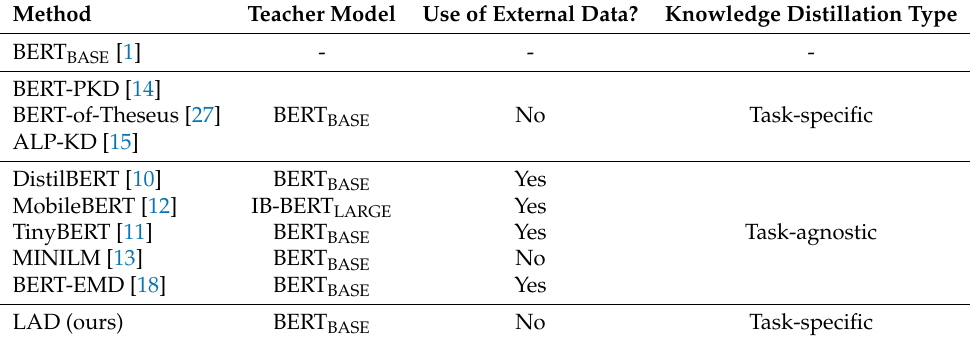
Table 1. Comparison with previous knowledge distillation approaches for transformer-based models.